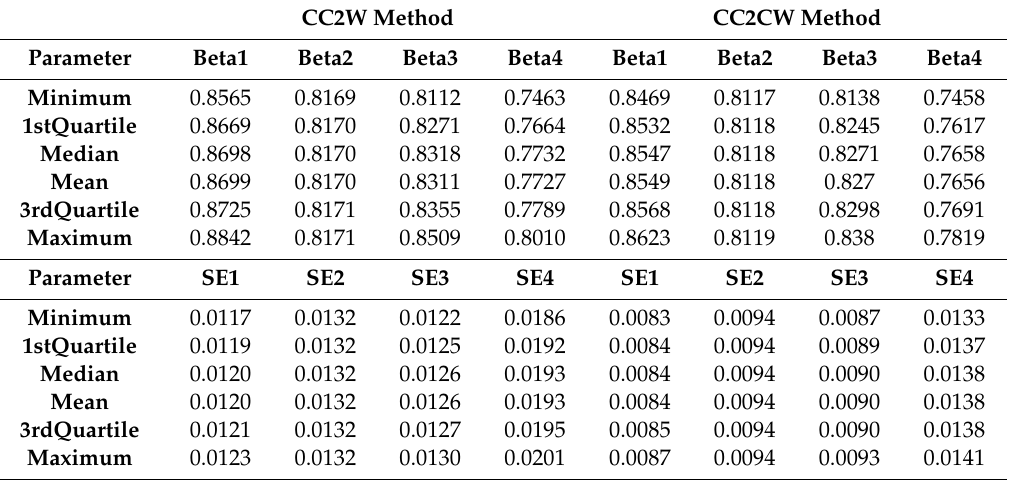
Table 2. Estimated parameters obtained for the CC2W and CC2CW